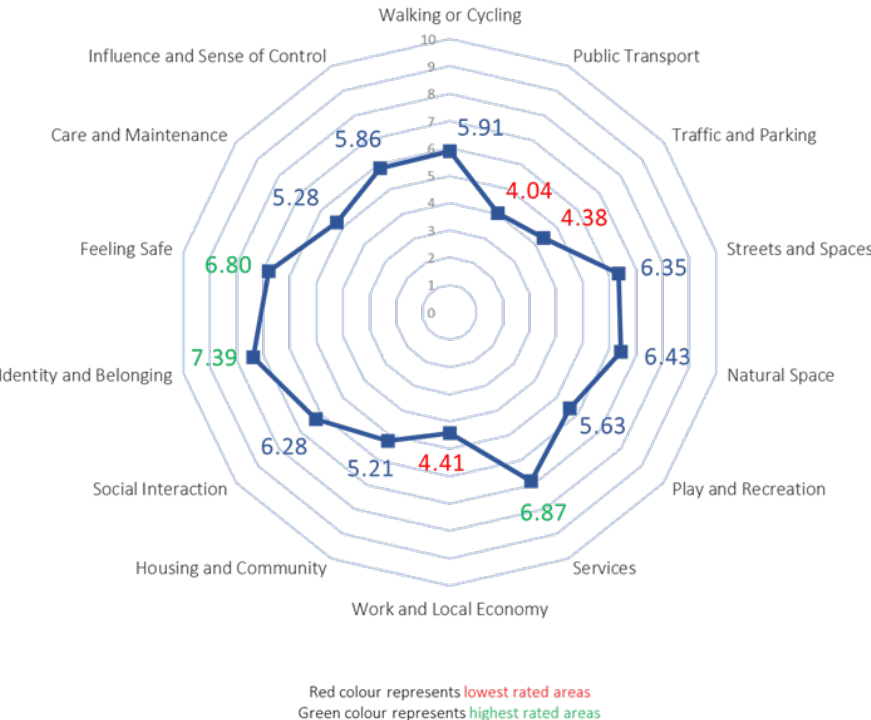
Figure 2. Summary of the mean scores obtained in the 14 items of the EdV tool. The internal consistency of the EdV questionnaire was measured with Cronbachs’s alpha reliability coefficient, obtaining a result of 0.849.